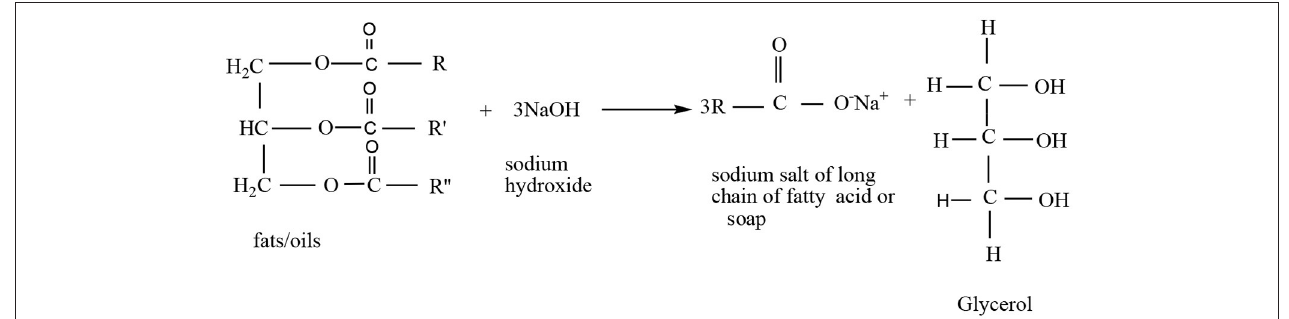
FIGURE 6 | The general scheme of preparation of